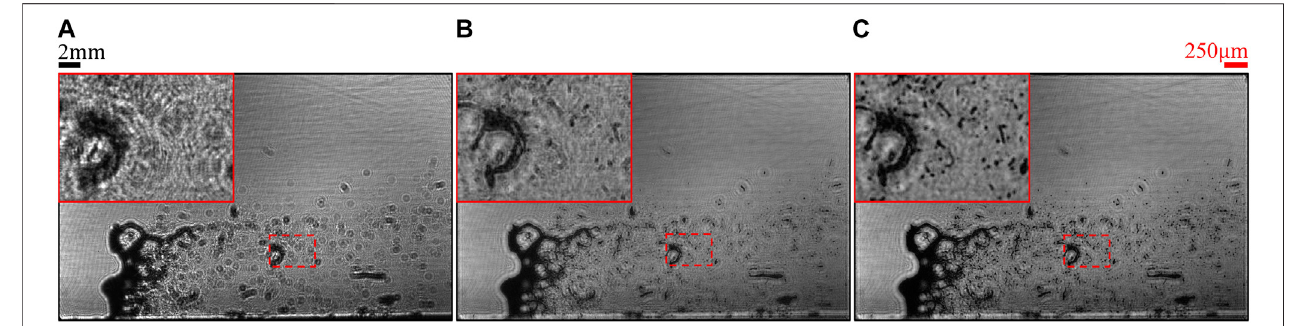
FIGURE2| Experimentaldataforcrossing- fl owatomizationofgelparticles.Imageswithblackboundaryaretheprimitiveimages.Imageswithredboundaryonthe left upper sideareenlargedones ofwhatthered dottedbox frames. Thesubgraph (A) istherawhologramobtained bythehigh speed camera.The subgraph (B) isone of the slices from a reconstructed hologram. The subgraph (C) is the EFI generated from all reconstructed slices.